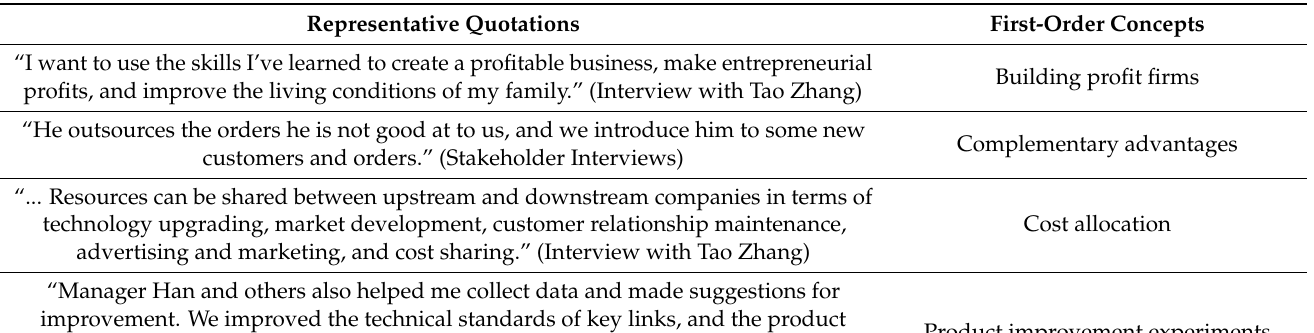
Table 2. Representative Quotations of Open Coding.